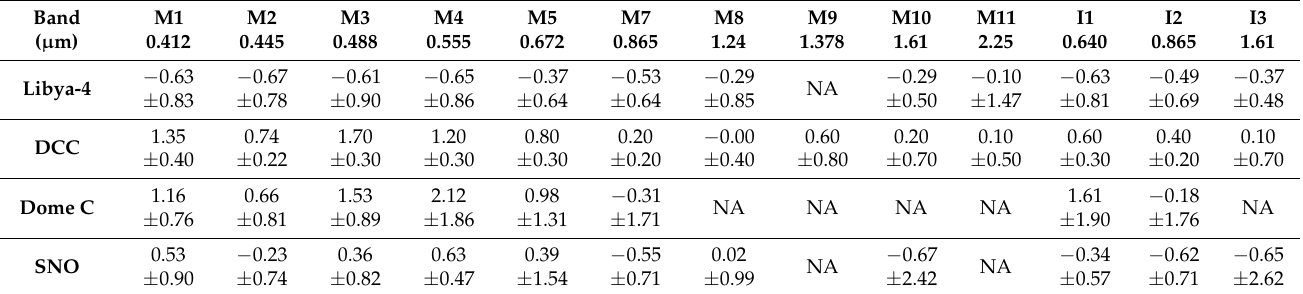
Table 3. SNPP VIIRS RSB stability from the four vicarious approaches. Results are provided in percentage for drift over the entire mission. Values denoted as ± are the standard error. Those marked “NA” are either not applicable or a data variation.